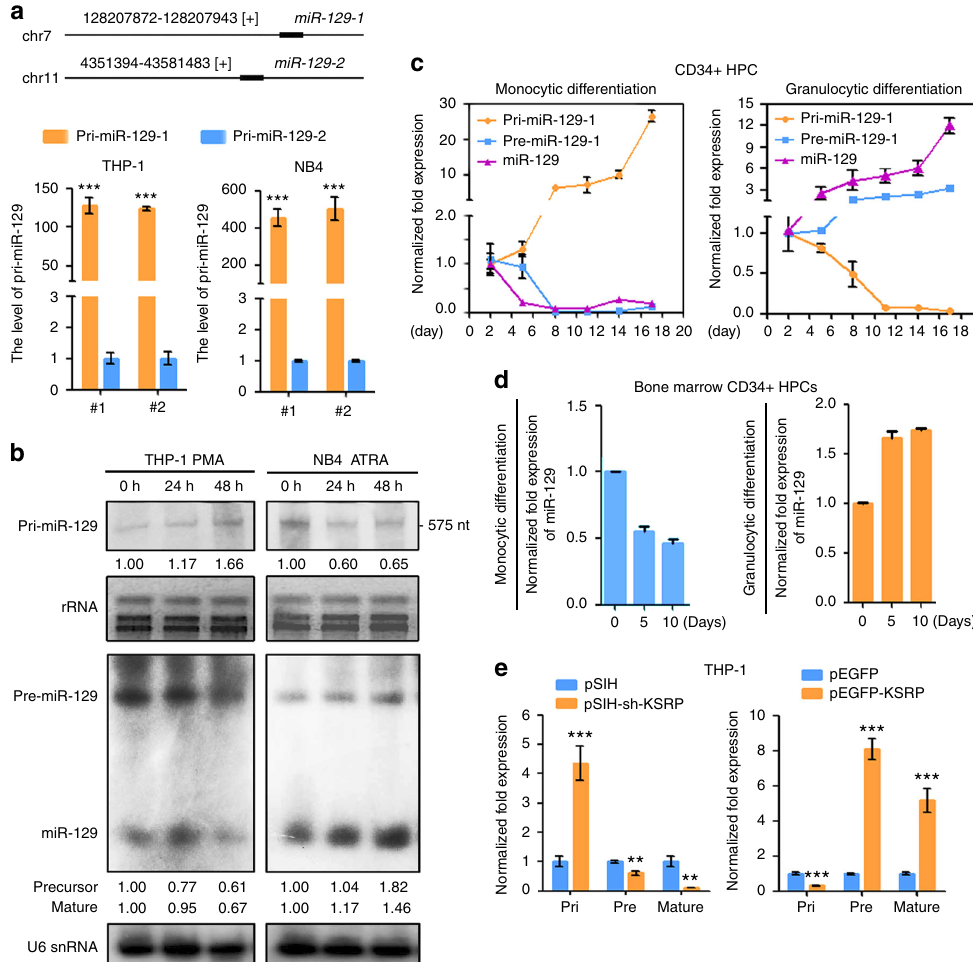
Fig. 4 KSRP regulates primary miRNA processing in myeloid cells. a Upper: schematic representation of two miR-129 loci in the human genome; lower: qPCR analysis of the relative abundance of the two pri-129 transcripts in THP-1 and NB4 cells. The expression of each transcript was normalized to pri-129- 2 using the ΔΔ Cq method. Three technical replicates from a single experiment representative of two independent experiments. b Northern blot analysis of miR-129 transcripts in THP-1 cells during monocyte differentiation and NB4 cells during granulocyte differentiation. The upper panels show the hybridization of pri-129-1 with digoxigenin (DIG)-labeled RNA probes; rRNA was used as a loading control. The lower panels show the hybridization of pre- miR-129-1 and miR-129 with isotope-labeled DNA probes; U6 snRNA was used as a loading control. Relative expression of pri-, pre-, and mature miR-129 was quanti fi ed using Image J software. c qPCR analysis of the expression of pri-129-1, pre-miR-129-1 and miR-129 in the CD34 + HPC models of monocytic and granulocytic differentiation. d qPCR analysis of the expression of miR-129 in the monocytic and granulocytic differentiation of bone marrow derived CD34 + HPCs. e Left: qPCR of the expression of pri-129-1, pre-miR-129-1 and miR-129 in THP-1 cells transfected with pSIH-sh-KSRP or pSIH control. Right: qPCR of the expression of pri-129-1, pre-miR-129-1 and miR-129 in THP-1 cells transfected with pEGFP-KSRP or the control. Three technical replicates from a single experiment. Data are shown as means ± s.d. ** P < 0.01, *** P < 0.001, Student ’ s t -test rabbit IgG was used as negative controls. Considerable number of proximity signals (dots) per nucleus was detected in samples incubated with anti-KSRP and anti-Drosha or anti-KSRP and anti-DGCR8 antibodies (Fig. 6e; Supplementary Fig. 5c), but not in the negative ones. Transcribed wild-type (129_WT) or KSRP-binding site mutant (129_Mut) pri-129-1 substrates were subjected to processing by HeLa cell nuclear extracts (NEs), which possess abundant amounts of the Drosha-DGCR8 complex, to determine whether KSRP modulates pri-129-1 processing in vitro. The addition of increasing amounts of the KSRP protein enhanced the cleavage ef fi ciency of 129_WT, whereas KSRP only slightly affected 129_MUT processing (Fig. 6f). Consistently, pri-let-7a proces-